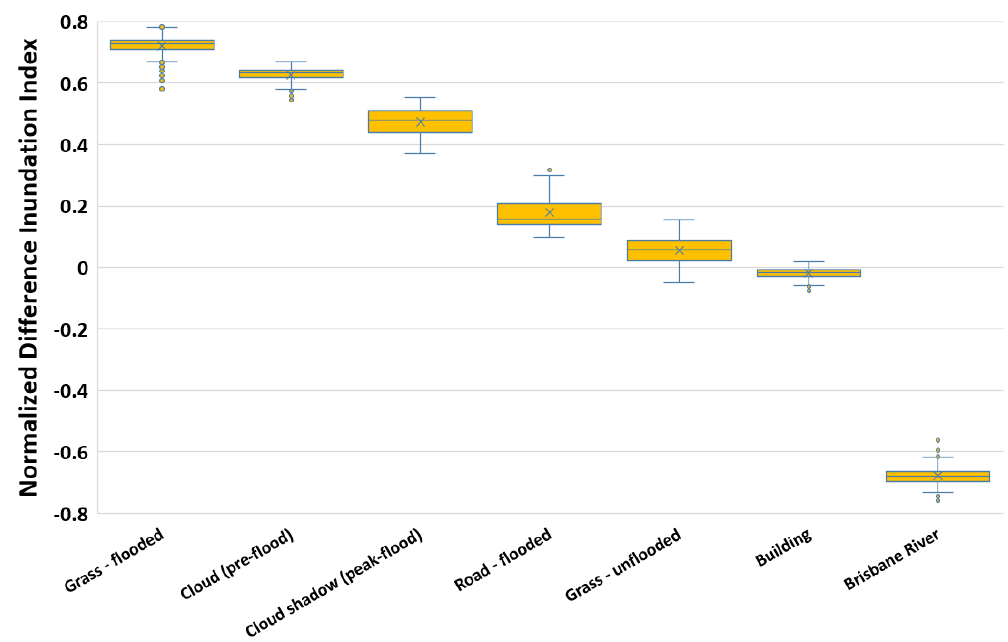
Figure 5. Box plots of the Normalized Difference Inundation Index (NDII) values for the regions of interest shown in Figure 4. We used a threshold of 0.1 to distinguish between flooded and unflooded areas. Note that pre-flood cloud or post-flood cloud shadows lead to false positives.